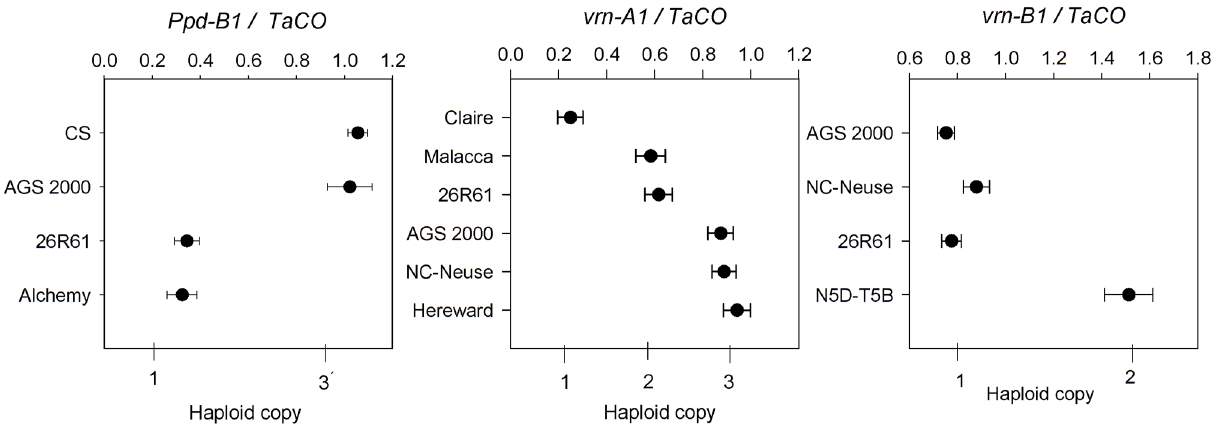
Fig 1. Copy number variation for PPD-B1 , VRN-A1 and VRN-B1 . TaqMan 1 estimates of haploid copy number in relation to internal positive control signal ratio (TaCO) for PPD-B1 , VRN-A1 and VRN-B1 . CS: Chinese Spring; N5D-T5B: Chinese Spring nullisomic 5D- tetrasomic 5B. Means and standard deviations of ten measurements are